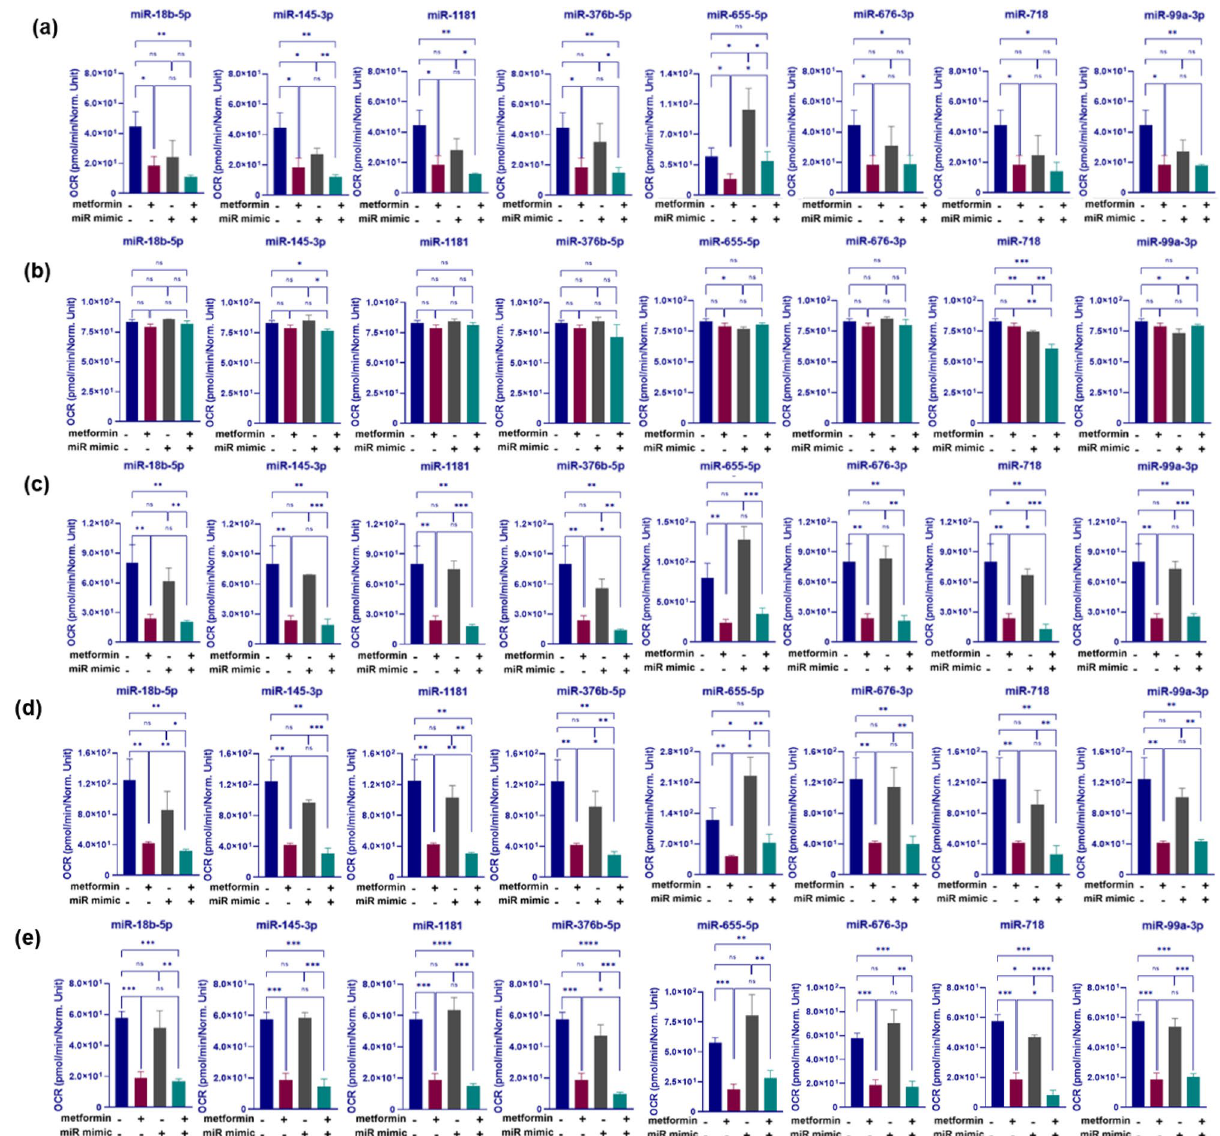
Figure 4. Changes in the reserved respiratory capacity ( a ), coupling efficiency ( b ), basal respiration ( c ), maximal respiratory capacity ( d ) and ATP synthesis ( e ) of HCT116 cells associated with miRNA mimic transfections in combination with metformin treatment. CRC cells were reverse transfected with selected miRNA mimics and treated with 2.5 mM metformin treatment or control medium. Oxygen consumption rate (OCR) of the cells was determined over a 30-min period using Seahorse XFe-96 instrument. The OCR values were normalized to viability of the corresponding cells acquired by crystal violet assay. Results are expressed as mean ± SD of 3 culture replicates and the statistical significance is indicated with asterisks (ns P > 0.05, *P ≤ 0.05, **P ≤ 0.01, ***P ≤ 0.001 and ****P ≤ lism, miRNA activity was increased by transfecting a panel of CRC cell lines (RKO, DLD1, HT29 and SW480), with miRNA mimics following 2.5 mM metformin treatment and cell viability was quantified. Among other CRC cell lines tested, RKO, DLD1 and HT29 cell transfections with miR-18b-5p, miR-145-3p, miR-1181, miR- 376b-5p, miR-676-3p and miR-718 mimics resulted in enhanced sensitivity of cells to the anti-proliferative effect of metformin (Supplementary Fig. 6). However, the SW480 cell line showed little sensitivity to several of these miRNAs. Only transfection with miR-18b-5p or miR-676-3p increased sensitivity of SW480 to metformin by decreasing the viability of the cells by 26% or 43% in combination with metformin ( P = 0.01 and 0.004, respec- tively), Supplementary Fig. 6. To investigate the roles of miR-1181, miR-18b-5p, miR-145-3p, miR-376b-5p, miR-676-3p and miR-718 mim- ics in combination with metformin on CRC cell death, caspase 3/7 activity was assessed as a marker of apoptosis. While transfection of four responsive CRC cell lines with miR-18b-3p, miR-145-3p, miR-1181, miR-376b-3p and miR-718 mimics, in combination with metformin treatment, showed no consistent pro-apoptotic function